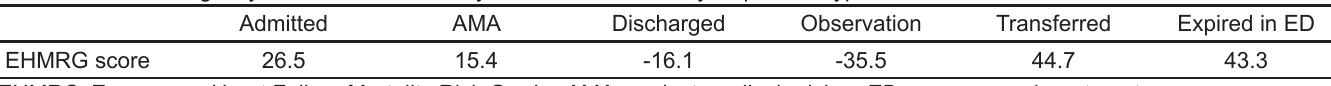
Table 2. Mean Emergency Heart Failure Mortality Risk Grade scores by disposition